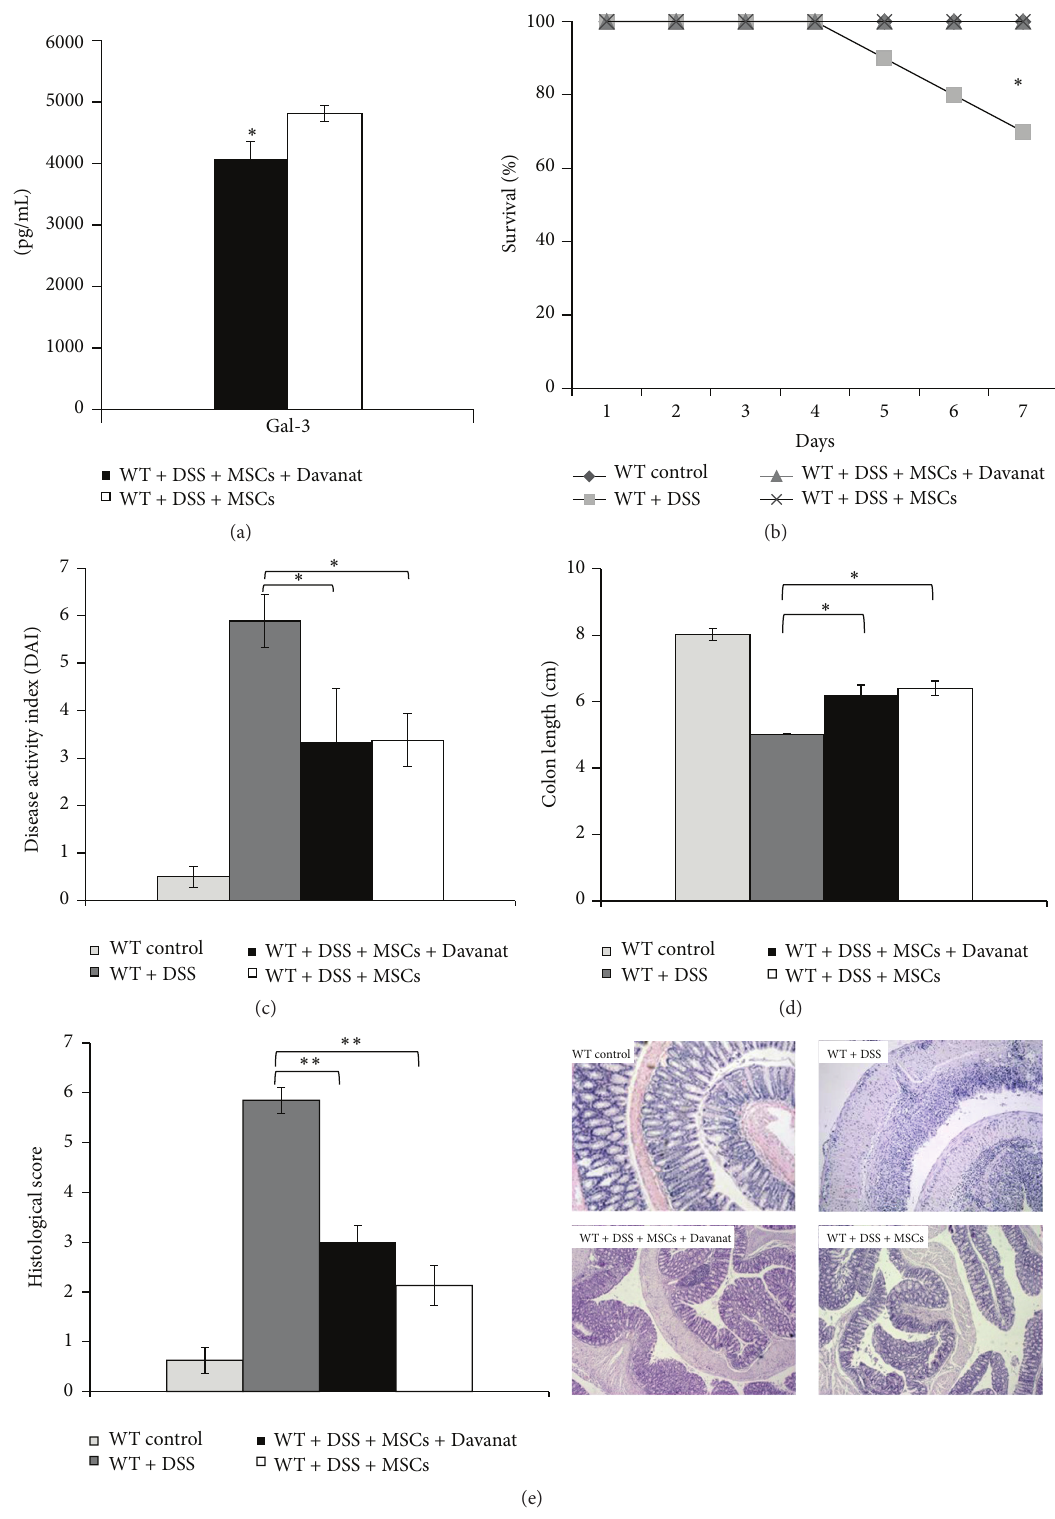
Figure 1: MSCs attenuate DSS-induced colitis. Water with 3% DSS was given to mice for 7 days; regular drinking water was fed to control mice. The concentration of Gal-3 in sera of MSCs groups (a). Survival rate of mice with colitis (b). Disease Activity Index (DAI) scored at day 7 using the following parameters: weight loss, stool consistency, and rectal bleeding (c). After DSS treatment length of the entire colon was measured (d). Histological examination was performed with hematoxylin and eosin staining (e). H&E staining images of representative colon tissues are shown at the same magnifications (100x) (e). Data presented as means ± SEM; 𝑛 = 10 mice per experimental groups. ∗ 𝑃 < 0.05 , ∗∗ 𝑃 < 0.01